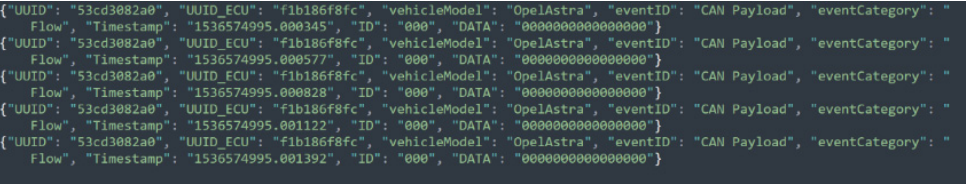
Figure 11. Example of JSON messages that correspond to DoS attack.